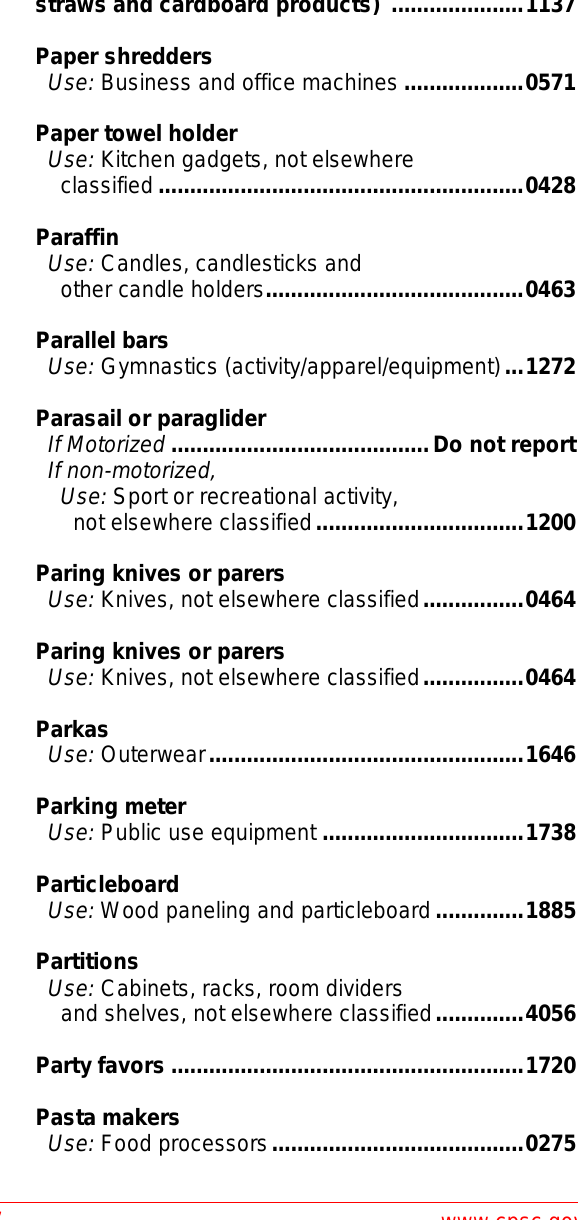
Paper plates, paper towels or other paper products Use: Paper products (excl. bags, cups, Paper products (excl. bags, cups,